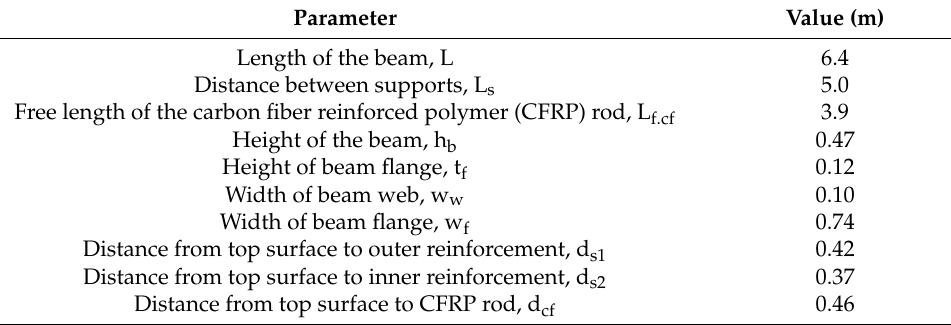
Table 1. Geometrical parameters of the T-beams, See Figure 2. Parameter